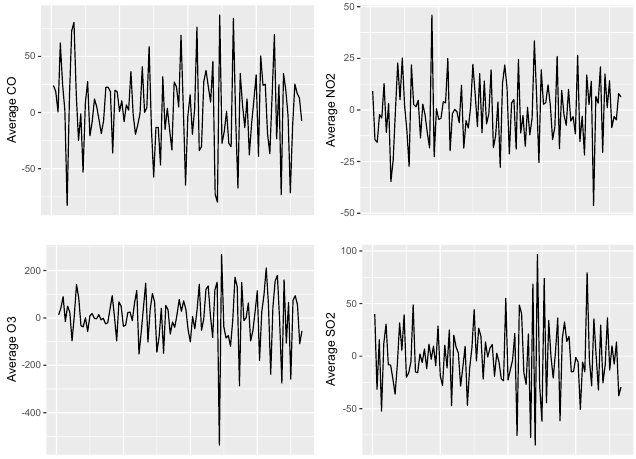
Figure 12. Example of the pollutants’ time series (NO 2 , SO 2 , O 3 in mg/m 3 and CO in ppb) from the same sensor in Niederkorn, after differentiation to remove the trend and seasonalities.